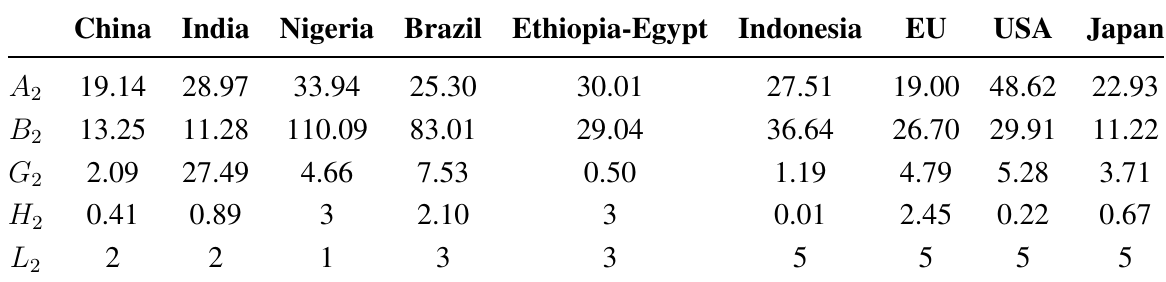
Table 2. Timescales (in Years) for logistic